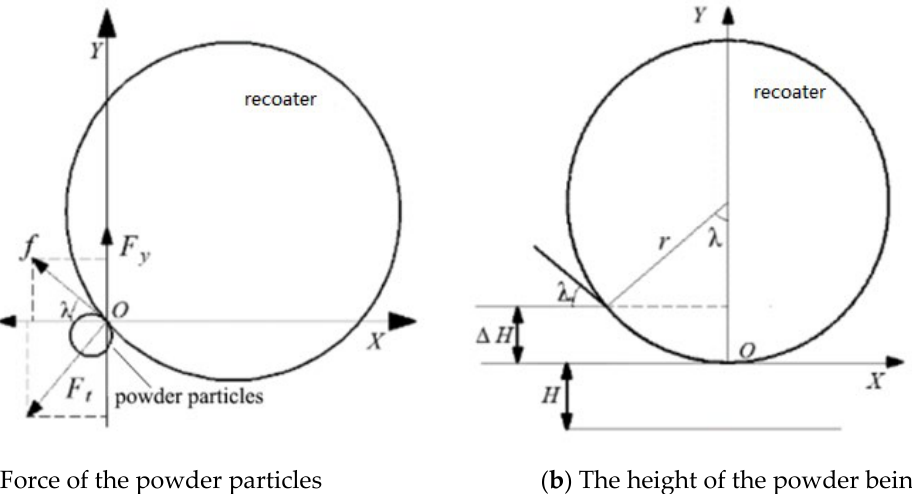
Figure 2. The force of the powder and the height of the compaction in the deformation zone.